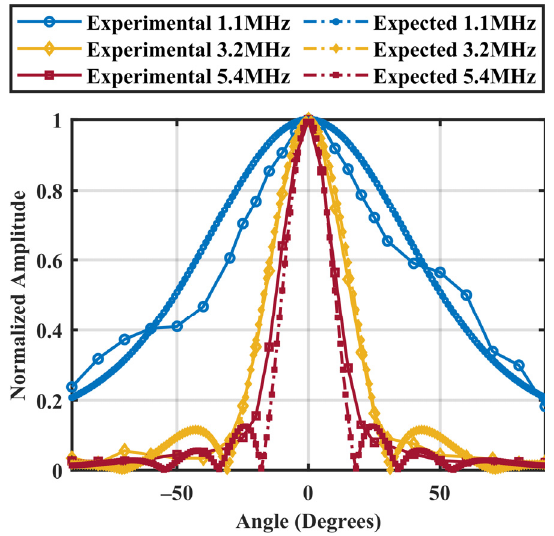
Figure 6. Theoretical and experimental directivity patterns of a PVDF receiver at discrete frequencies of 1.1, 3.2, and 5.4 MHz.